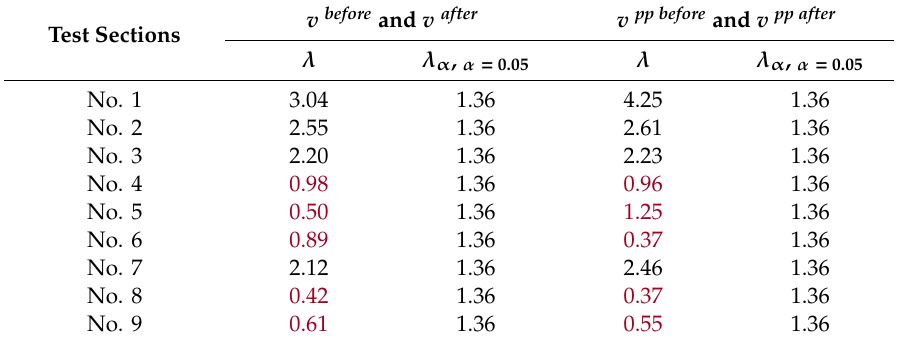
Table A3. Results of goodness-of-fit test on subsequent test sections (free speed v after and vehicle flow speed v pp after ).